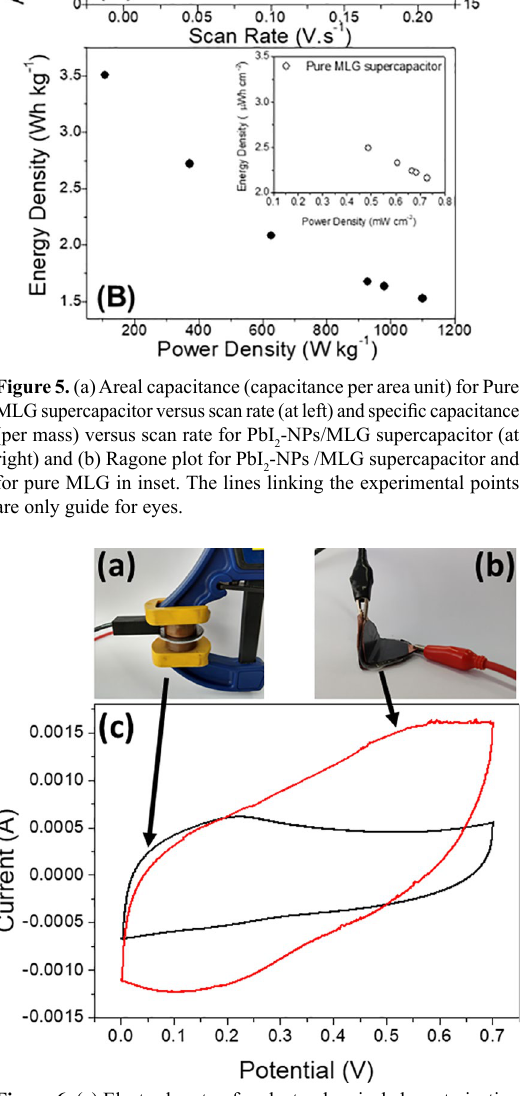
Figure 6. (a) Electrode setup for electrochemical characterization in line 0 angle, (b) in 90 degrees bend angle and (c) the CV curve at 0.005 V.s -1 at the 0 and 90 degrees